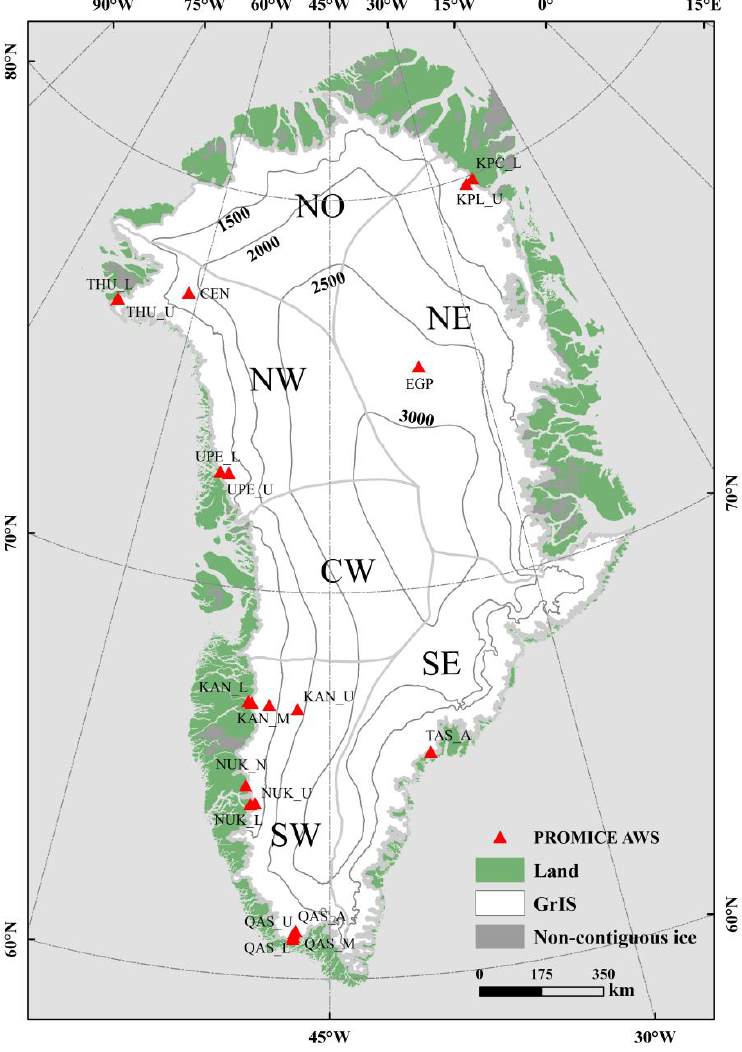
Figure 1. Map of the location of the GrIS, dividing the area according to Rignot et al. NO: North, NE: Northeast, SE: Southeast, SW: Southwest, CW: Central and West, NW: Northwest. Elevation contour lines are also represented (m).